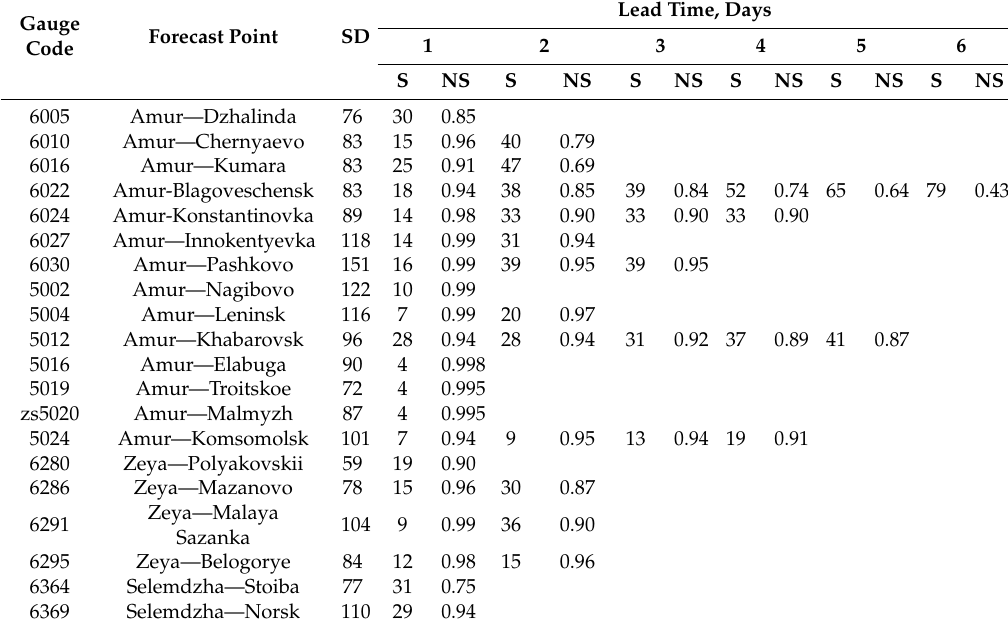
Table 1. Operational water level forecasts performance during 2015–2017 warm periods (May–September): water level standard deviation (SD, cm), root mean squared error (S, cm), and Nash–Sutcliffe efficiency